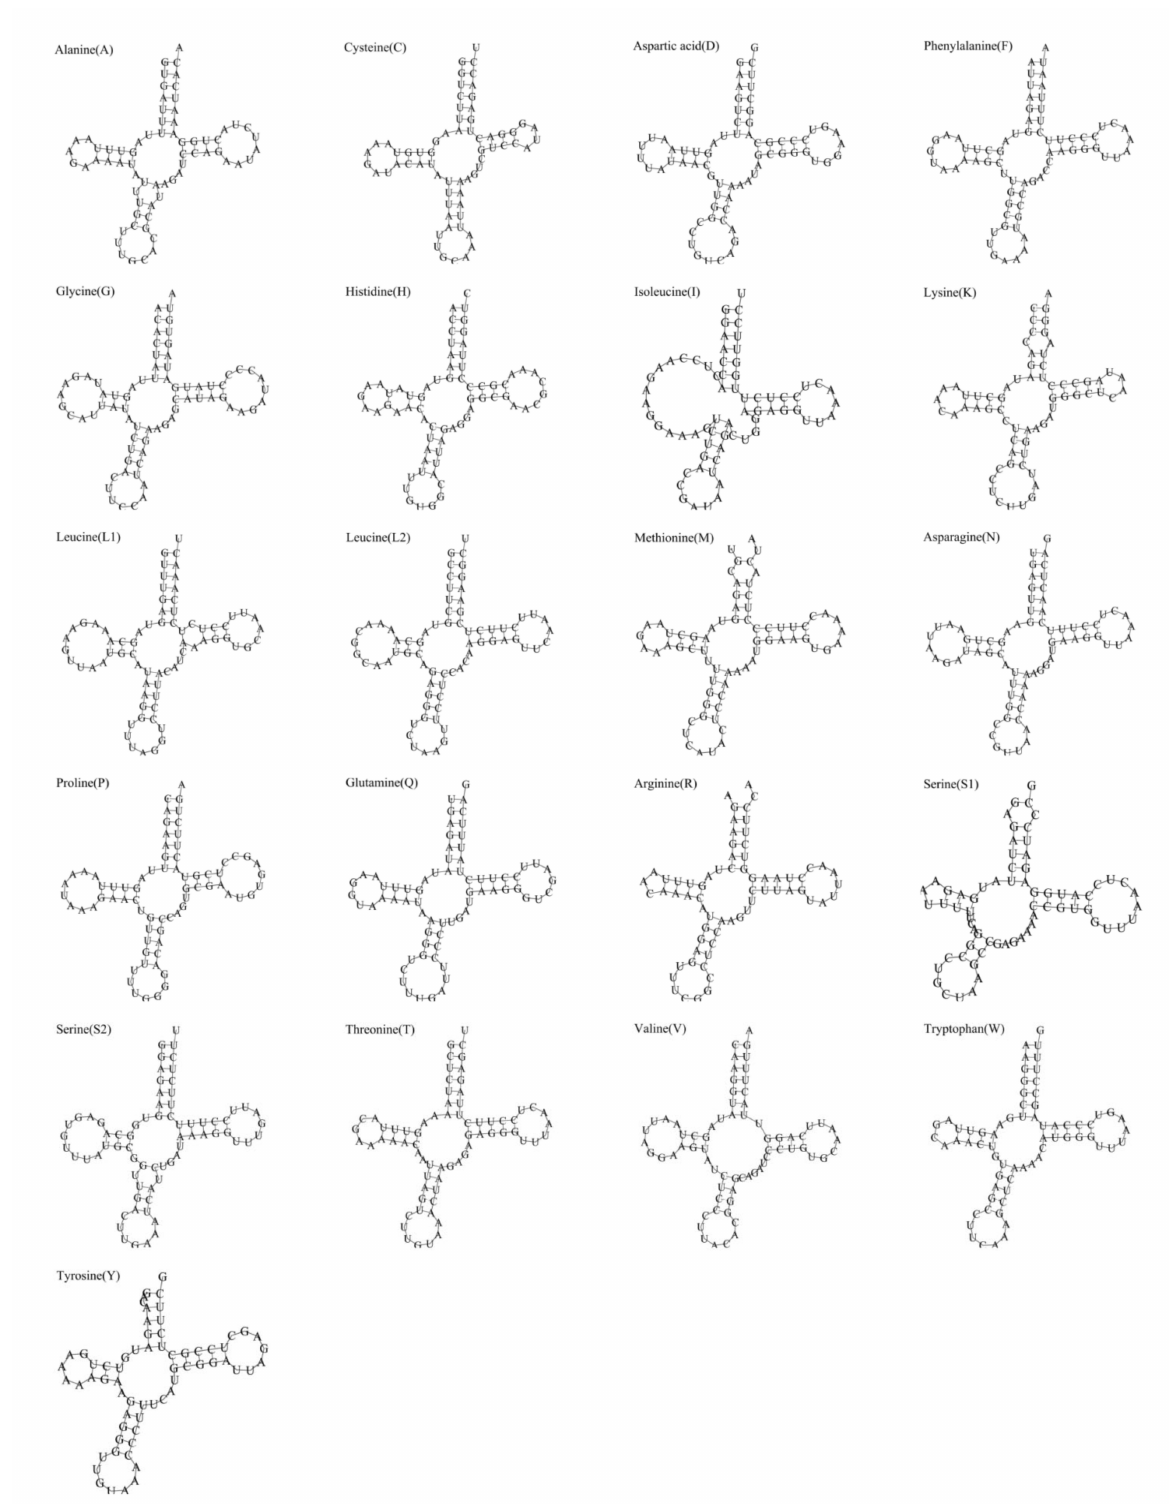
Figure 3. Secondary structure of tRNAs in the mitochondrial genome of B. argus